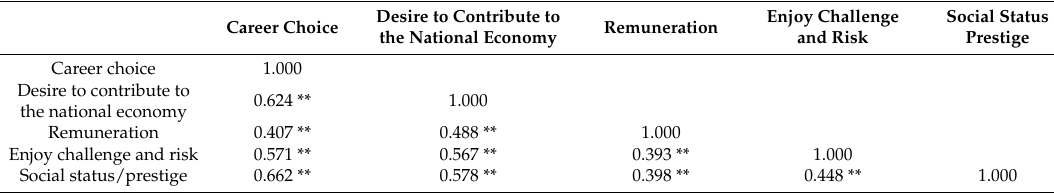
Table 8. Inter-correlation between perception about career choice and goal